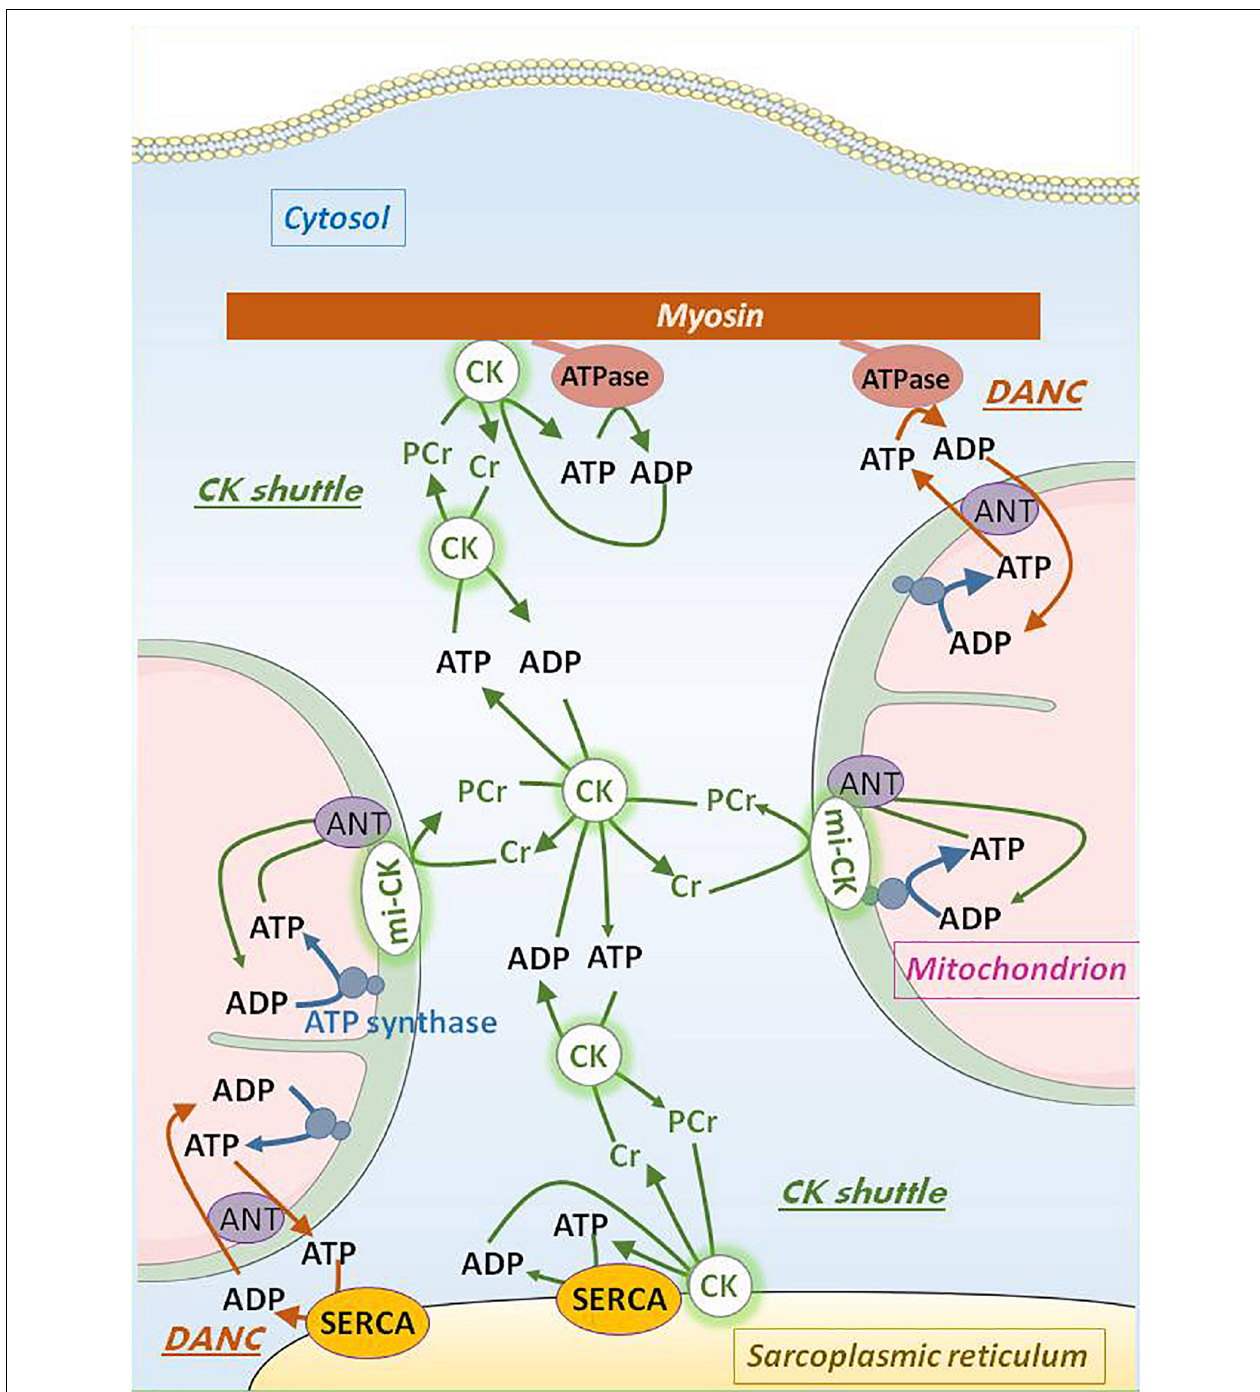
FIGURE 2 | Intracellular adenine nucleotide transport by DANC and CK shuttle in oxidative muscle cells. ATP generated in the mitochondrial matrix by ATP synthase is transported by adenine nucleotide translocase (ANT) across the inner mitochondrial membrane to the intermembrane space whereas ADP is transported by ANT in the opposite direction. Co-localization of the mitochondria with cell ATPase (like myosin ATPase or sarcoplasmic reticulum Ca 2 + -ATPase, SERCA) allows for bi-directional direct adenine nucleotide channeling (DANC). Functional mitochondrial creatine kinase (mi-CK) coupled with ANT uses ATP and creatine to produce phosphocreatine (PCr) which diffuses in the cytosol, and ADP which is taken back in the matrix by ANT. MM-CK bound to different organelles near ATPases traps cytosolic PCr to locally rephosphorylate ADP thus replenishing local ATP concentration near ATPases. Creatine liberated by this reaction can be reused by mi-CK. Cytosolic soluble MM-CK maintains the equilibrium between all chemical actors of the CK shuttle (ATP, ADP, PCr, and creatine). Relatively high cytosolic concentrations of PCr and creatine make efficient the bi-directional flux of these two substances.